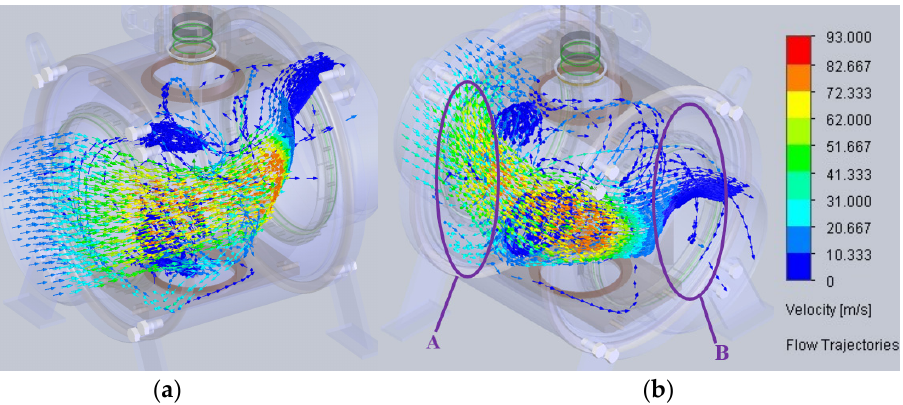
Figure 7. Velocity line trajectories for a 45° closure angle: ( a ) upstream view; ( b ) downstream view.